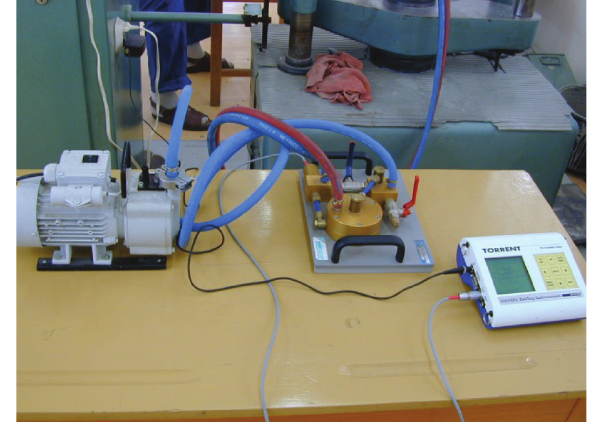
Fig. 4. Full set of Torrent permeability tester